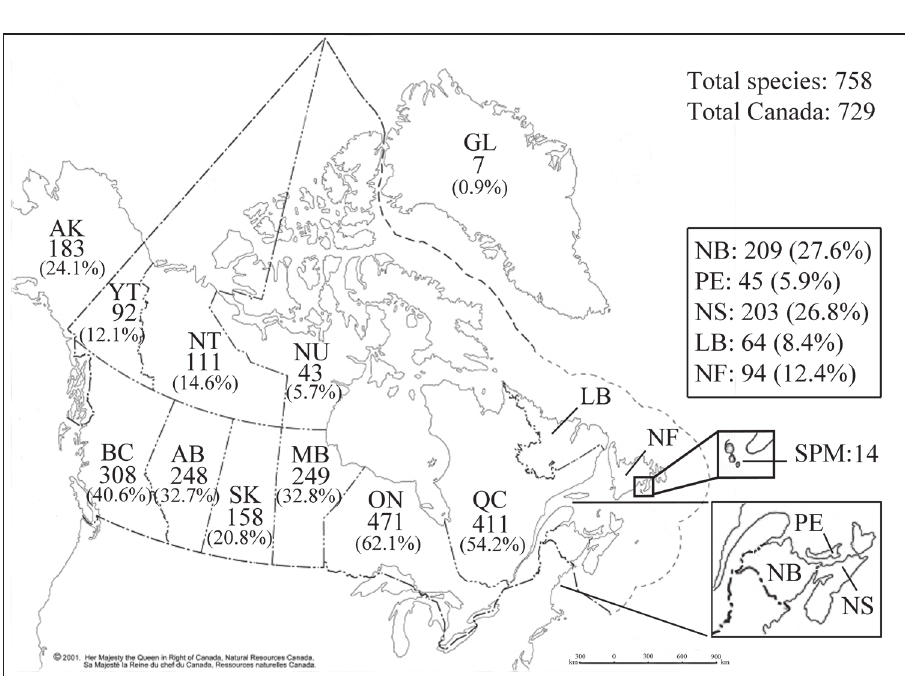
Figure 1. Map of Canada, Alaska and Greenland showing number of described, recorded sawfly species and percentage of total species for each region. Canada is comprised of all regions except for Alaska and Greenland. See Methods, Presentation of data section for acronyms of regions treated in the